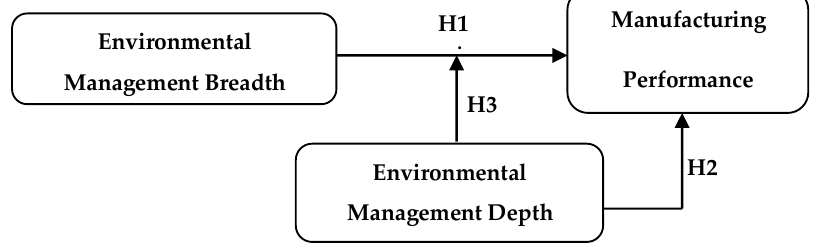
Figure 1. Theoretical framework.